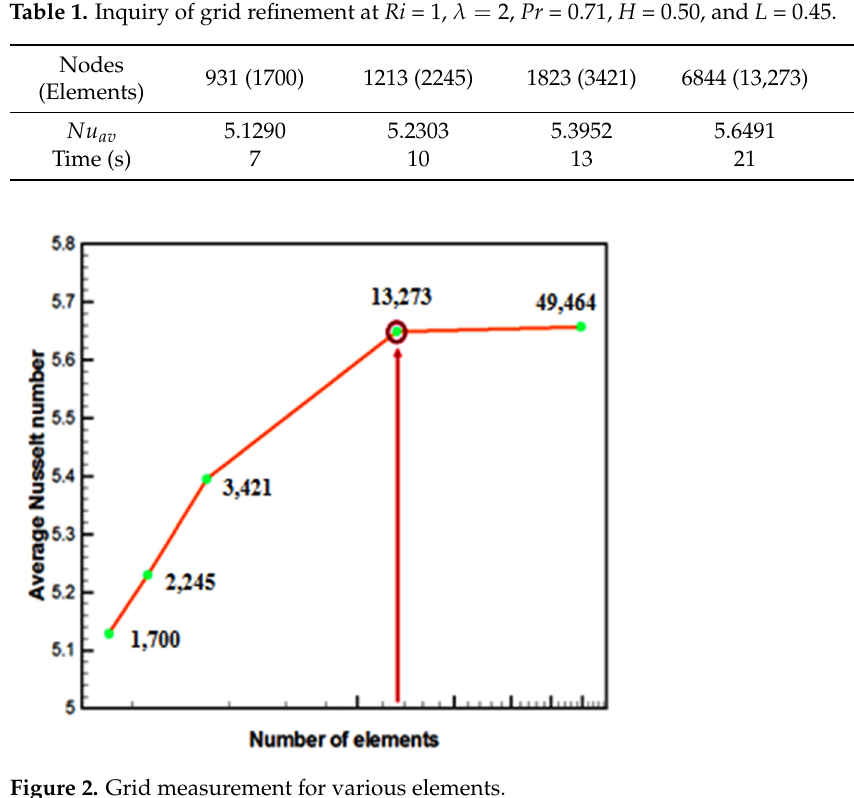
Figure 2. Grid measurement for various